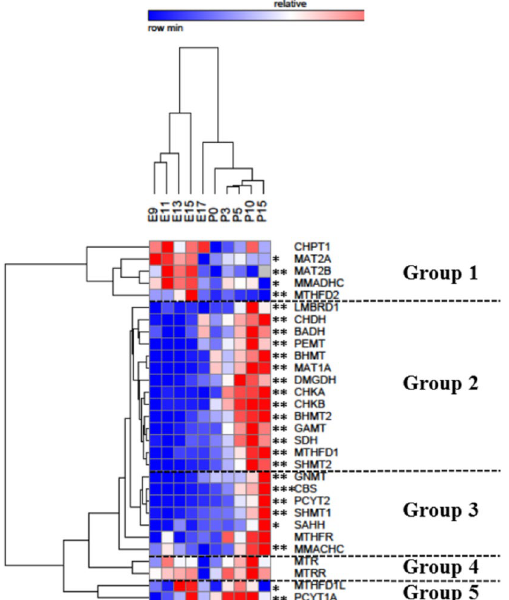
Figure 2. Two way hierarchical clustering of expression profiles for genes involved in 1C metabolism during liver ontogenesis. The two trees describe the relationship between different gene expression profiles (left tree) and various ages (upper tree). The dendrogram scale represents the correlation distances. Average expression values of three replicates per age are given by colored squares: red, relatively high expression; blue, relatively low expression. The dashed line categorizes the genes according to their expression profiles into five major groups. Stars represent the result of the Kruskall–Wallis test: *significant at the 0.05 level; **significant at the 0.01 level; ***significant at the 0.001